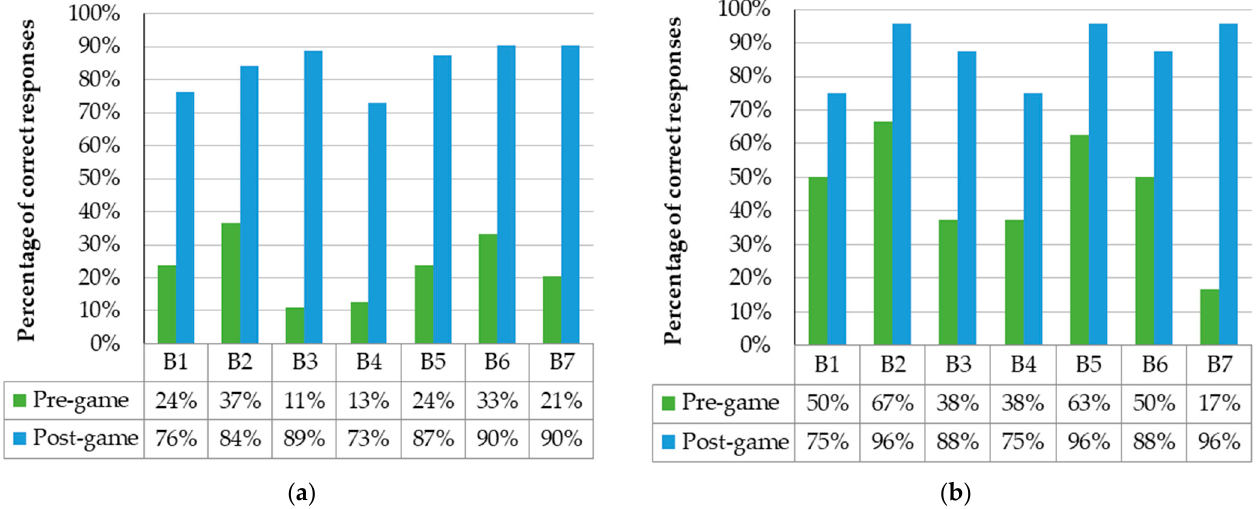
Figure 10. Correct pre-game and post-game responses of undergraduate and graduate students.